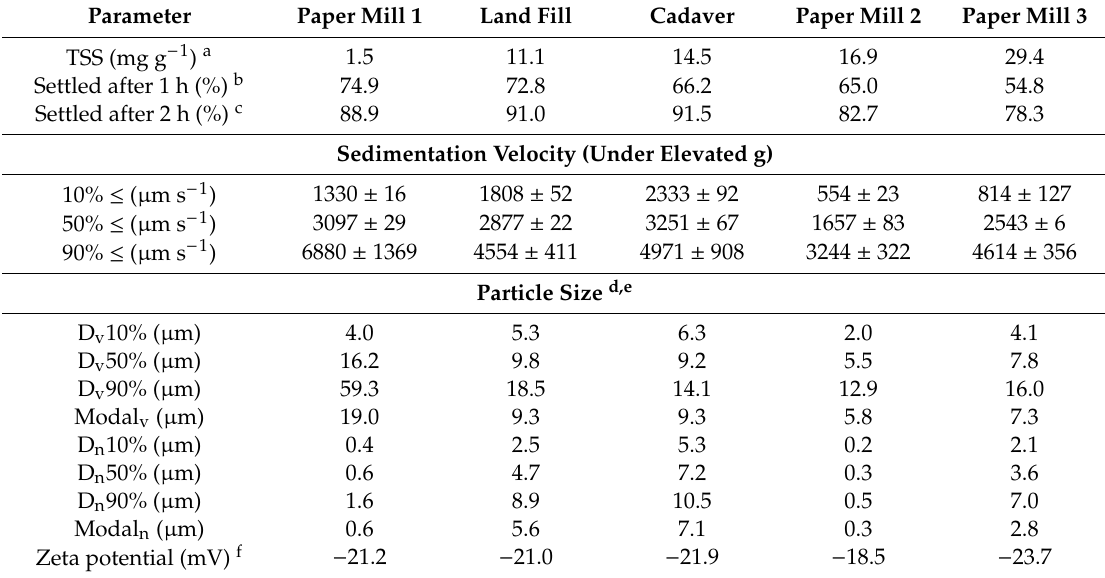
Table A1. Particle properties of samples harvested from the five industrial facilities.